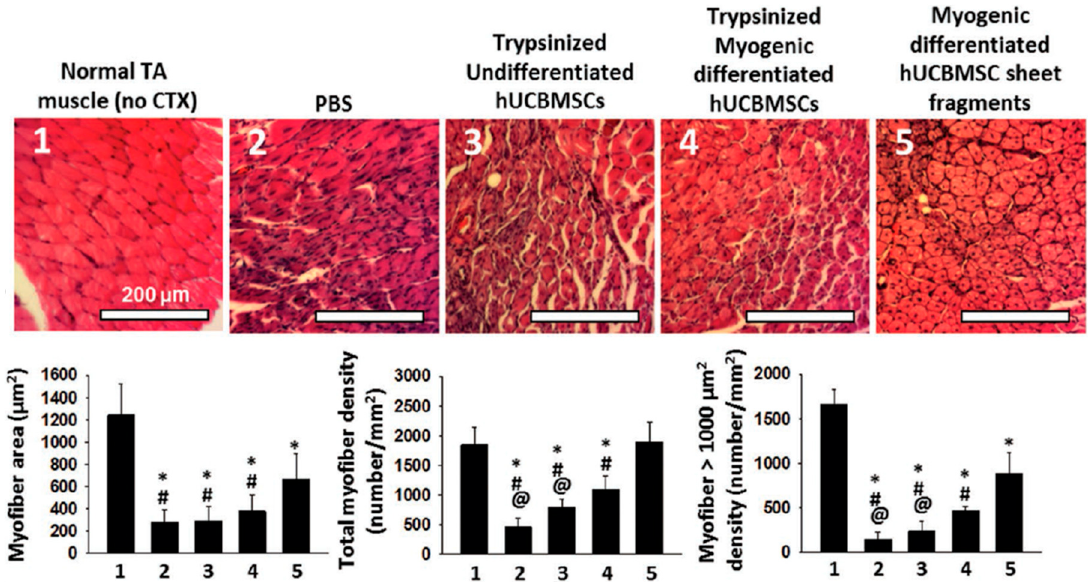
Figure 6. Skeletal muscle regeneration after transplantation of myogenically differentiated human umbilical cord blood mesenchymal stem cell (hUCBMSC) sheet fragments in cardiotoxin (CTX)-induced mice models. hUCBMSC derived myogenic differentiated cell sheets improved tibialis anterior (TA) muscle regeneration estimated by hematoxylin and eosin staining. Restoration of TA muscle specific extracellular matrix (ECM) (laminin) Scale bar = 100 μ m. Reproduced with permission from [110].